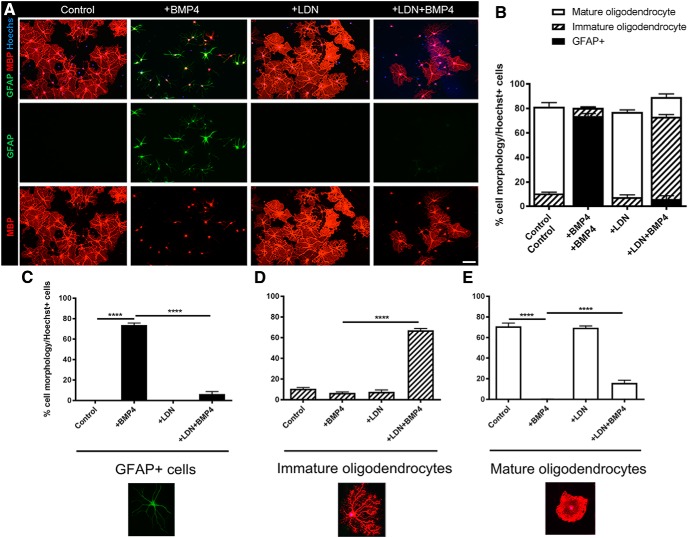
BMP4 signals via BMPR1 in OPCs to enhance oligodendrocyte differentiation and reduce astrogliogenesis in vitro.
A, Representative micrographs of immunostaining of differentiated OPC cultures for MBP and GFAP under untreated (Control) conditions, or following treatment with BMP4, LDN-193189 (LDN), or both BMP4 and LDN-193189 (LDN+BMP4). B, Quantification of cell phenotypic distribution for each condition based on GFAP expression and MBP+ morphology. MBP+ cells were classified as either mature (flattening of branched extracellular membrane) or immature (branched morphology but not fused layers). C, Quantification of the proportion of GFAP+ cells in the cultures. BMP4 significantly increased the proportion of GFAP+ cells compared with untreated (Control) cultures. While LDN-193189 (LDN) alone exerted no significant effect, pretreatment with LDN before BMP4 (LDN+BMP4) significantly abrogated effect of BMP4 on astrocytes. D, Quantification of the proportion of immature oligodendrocytes in the cultures. Treatment with BMP4 or LDN-193189 (LDN) exerted no significant effect, whereas pretreatment with LDN-193189 before BMP4 (LDN+BMP4) significantly increased the proportion of immature oligodendrocytes. E, Quantification of the proportion of mature oligodendrocytes in the cultures. Treatment with BMP4 significantly blocked OPC differentiation, whereas LDN-193189 (LDN) alone exerted no significant effect. Pretreatment with LDN before BMP4 (LDN+BMP4) significantly abrogated the effect of BMP4 on oligodendrocyte differentiation (N = 4 animals/group). ****p < 0.0001. Scale bar, 20 µm.